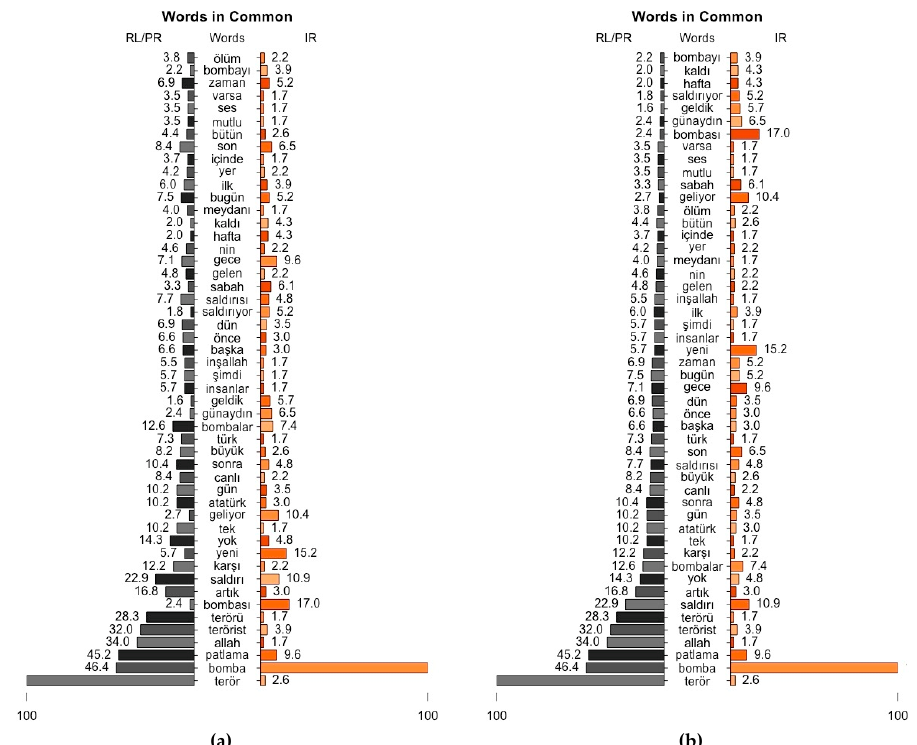
Figure 11. Pyramid plots (a) ordered by the term frequency difference between RL/PR and IR and (b) ordered by the term frequency in